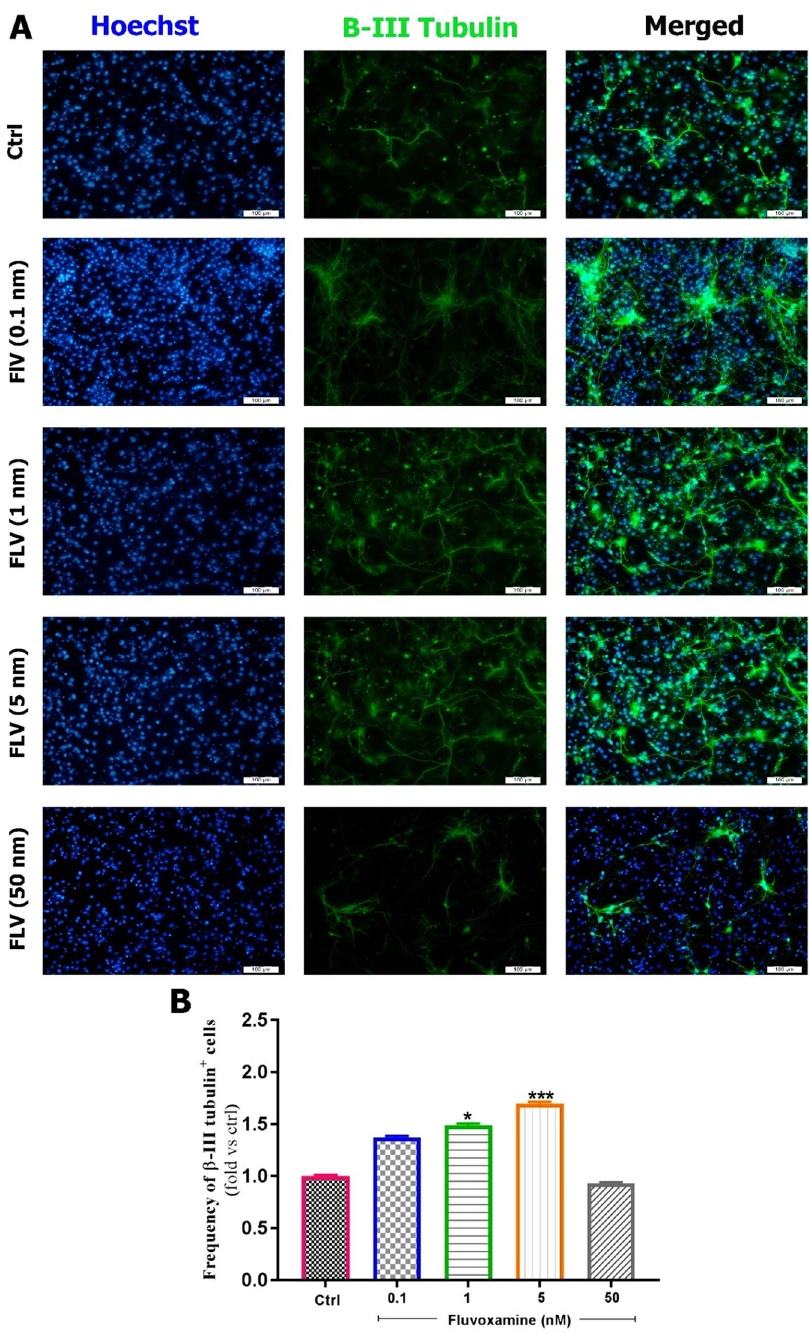
Figure 5. Effect of fluvoxamine on eNSC differentiation to neurons. ( A ) Representative images of differentiated embryonic NSCs stained with β -III Tubulin (a neuronal marker, green) and Hoechst (a nuclei marker, blue) in control and treated groups at day 6. White scale bars indicate 100 µ m. ( B ) Quantification of the frequency of β -III Tubulin positive cells in treated groups, which has been normalized to controls. Results showed that 5 nM is the best concentration for differentiation of eNSCs to neurons. Each group included 3 replicates (n = 3). Values are reported as mean ± SEM for 15 field/well. Statistical analyses were performed by ANOVA followed by Tukey test. * p < 0.05; ** p < 0.01; *** p < 0.001 and **** p <